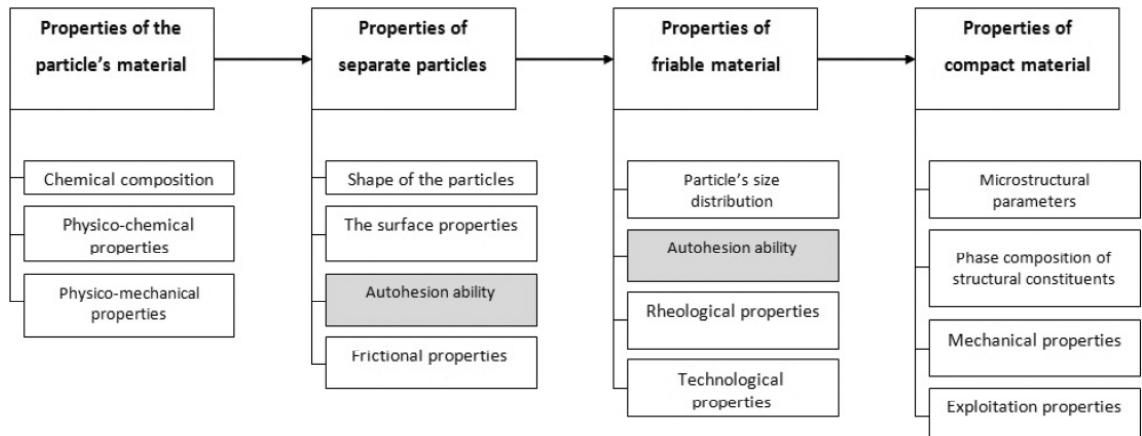
Fig. 1. Classification of the properties of powder materials (replotted regarding to the data from